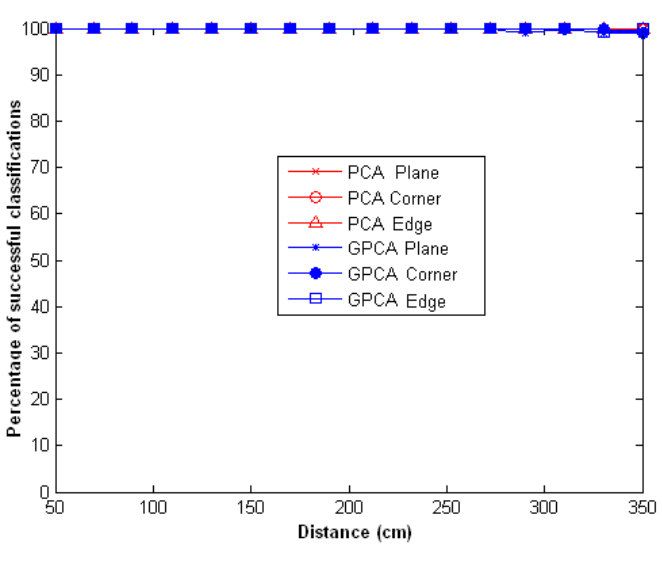
Figure 5. Percentage of successful classifications using GPCA and PCA, for l = l and m =